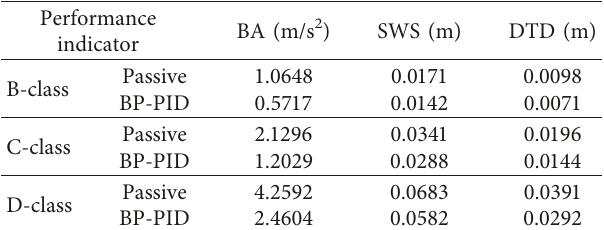
Table 3: RMS values of suspension performance indicators under different